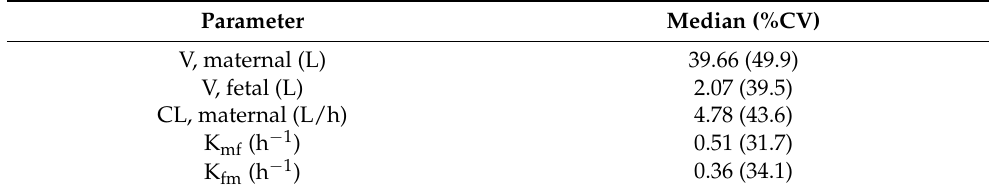
Table 1. Pharmacokinetic parameter estimates.